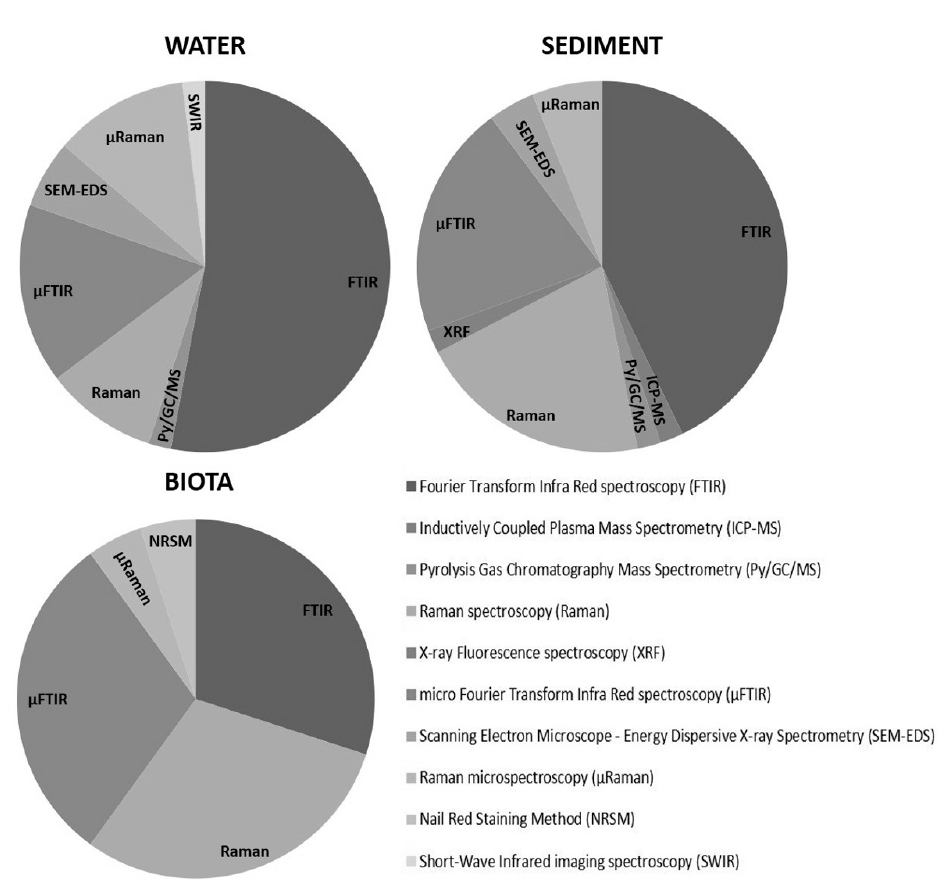
Figure 8. Techniques for identifying the polymers used for microplastics.